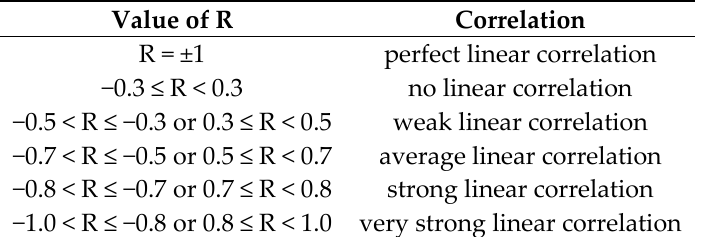
Table 1. PCC values and explanations.